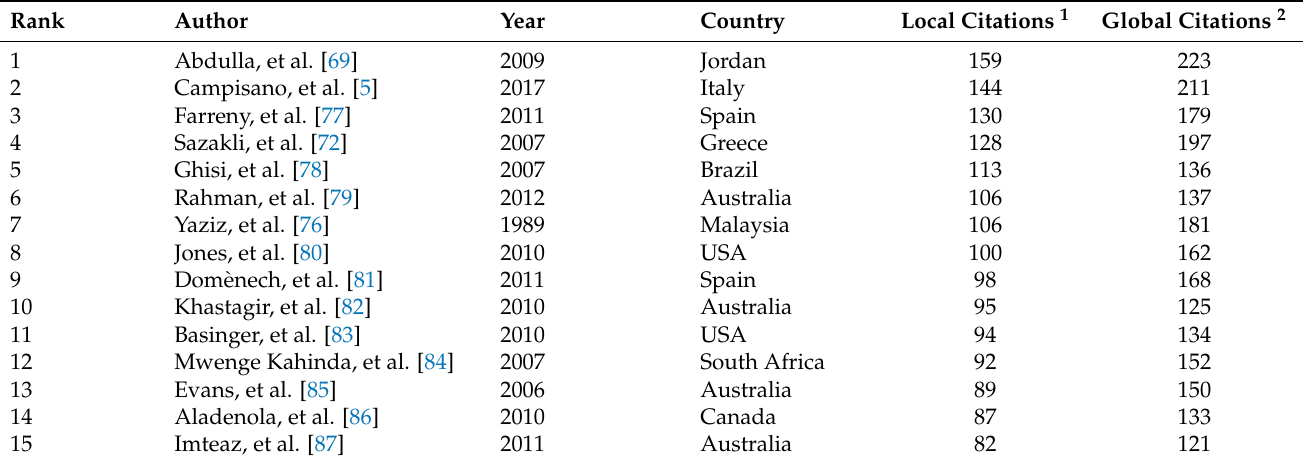
Table 5. The top 15 articles’ citation measure in RWH